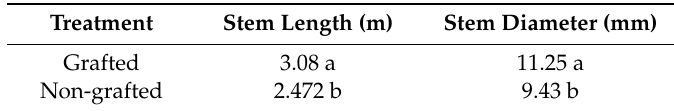
Table 1. Effect of grafting on watermelon growth